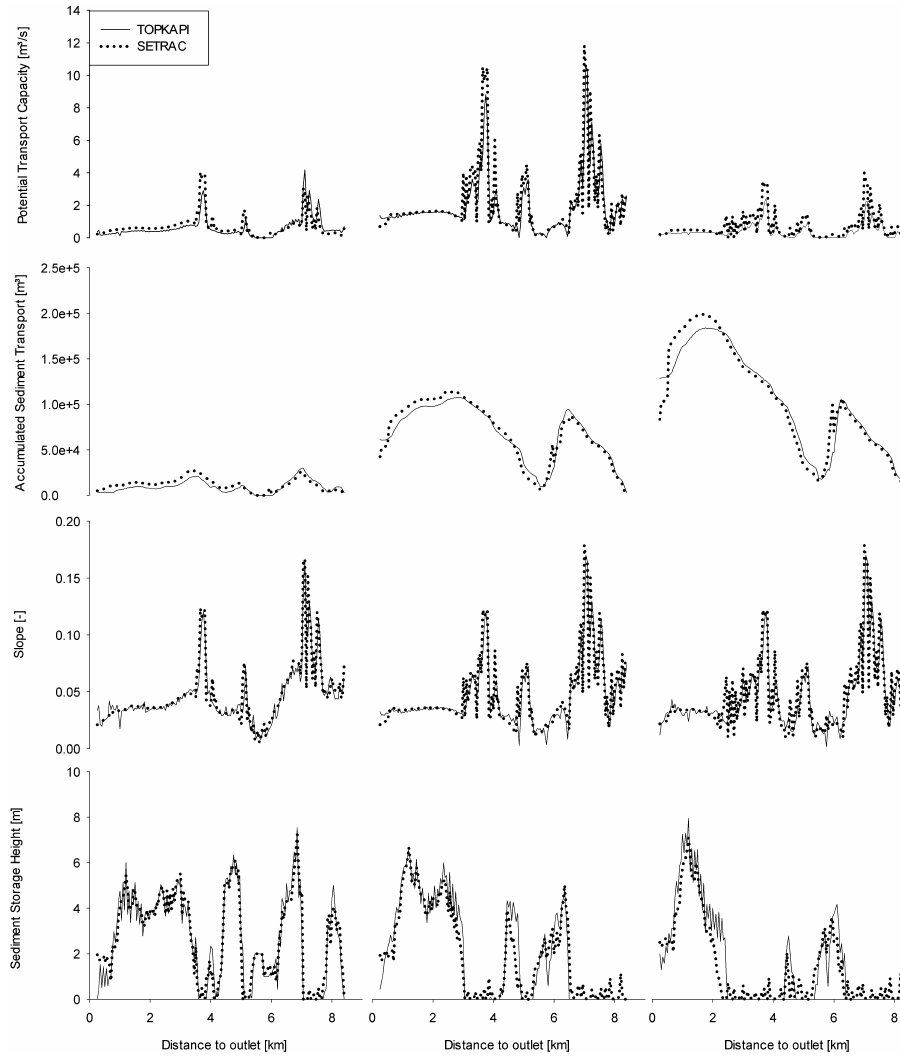
Fig. 6. Detailed comparison of TOPKAPI and SETRAC for setup